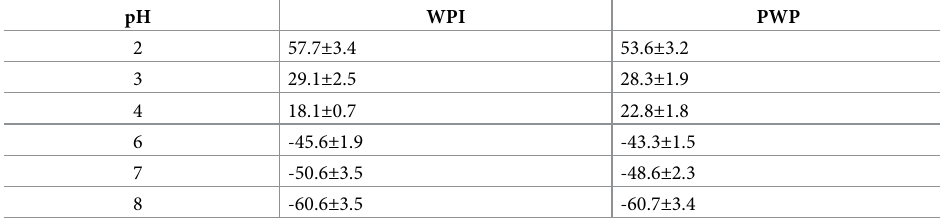
Table 3. Effect of pH on the zeta-potential of the